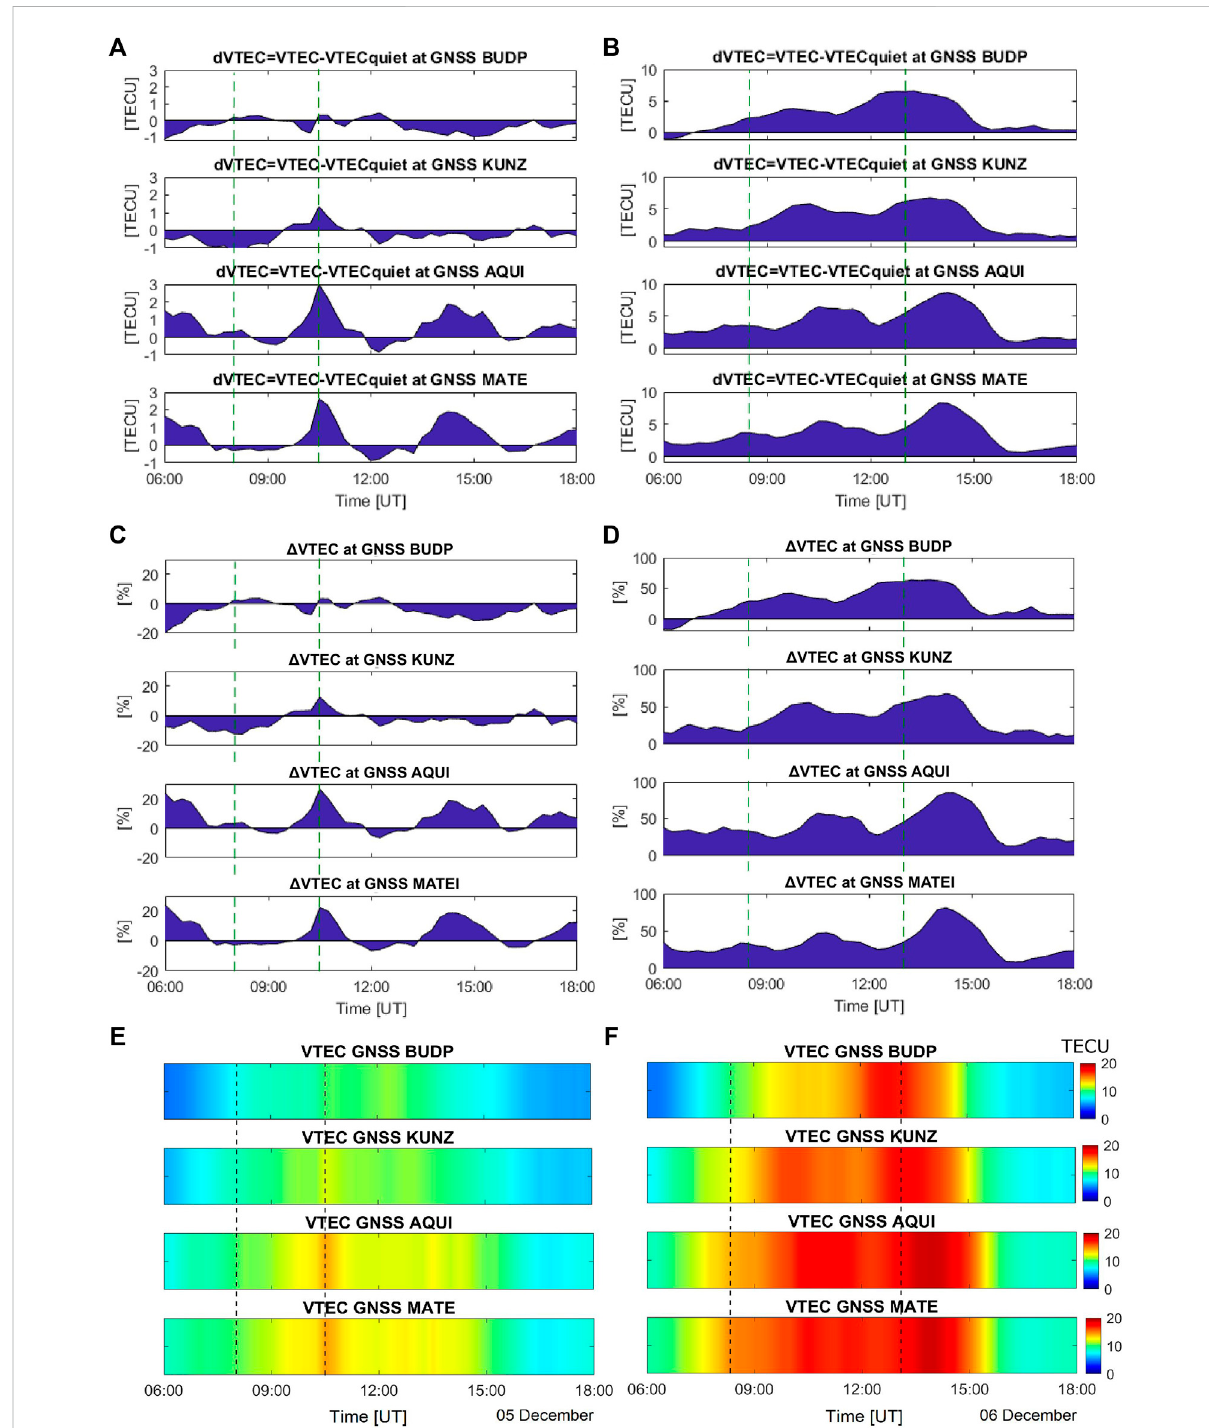
FIGURE 8 05 December 2006: The dVTEC (A) and Δ VTEC (C) on 05 December. Green dashed lines represent the peaks of solar fl ares, i.e., 08:03 UTC (M1.8) and 10:35 UTC (X9.0). The dVTEC (B) and Δ VTEC (D) on 06 December. Green dashed lines represent the peak of solar fl ares, i.e., 08:23 UTC (M6) and 12:58 UTC (C4.8). Colormap of VTEC values measured at the different stations during 05 December (E) and 06 December 2006 (F) . Black dotted lines represent the peak of solar fl ares: 08:03 UTC (M1.8) and 10:35 UTC (X9.0) on 05 December, 08:23 UTC (M6) and 12:58 UTC (C4.8) on 06 December